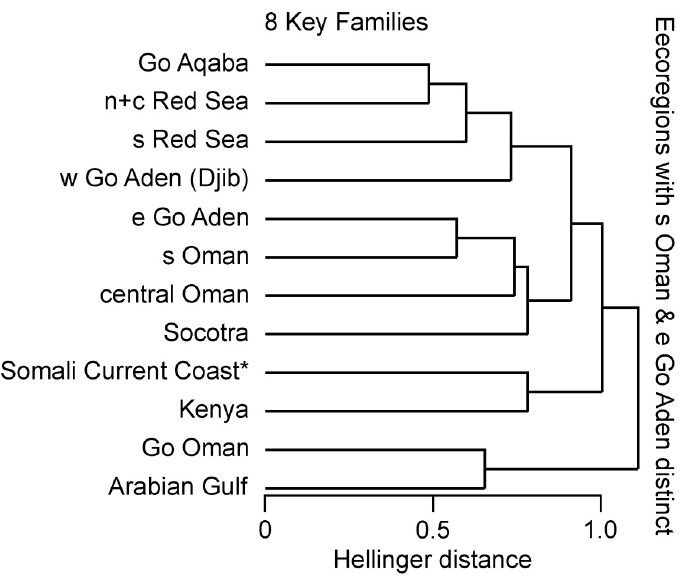
Fig 5. Resemblance pattern of 10 putative Arabian ecoregions and Kenya (8 key families, 404 species) based on Hellinger distance, represented as plot of the dendrogram of the hierarchical agglomerative cluster analysis, according to separate checklists for the eastern Gulf of Aden (e Go Aden) and southern Oman (s Oman), verifying the proposed Eastern Gulf of Aden extended (e Go Aden ext.) ecoregion used in the analysis presented in Table 1 and Fig 4.